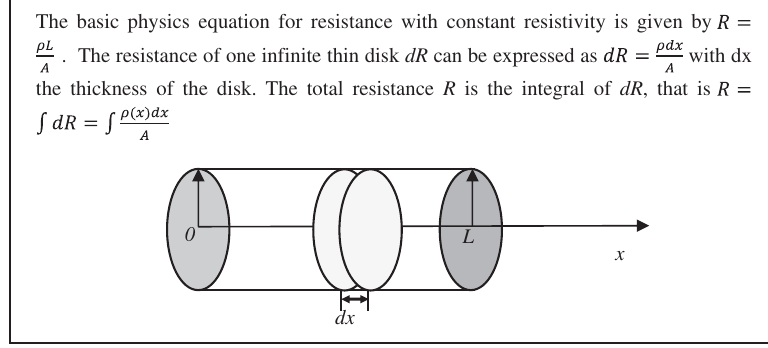
FIG. 4. Partial solution to the interview task in Fig.